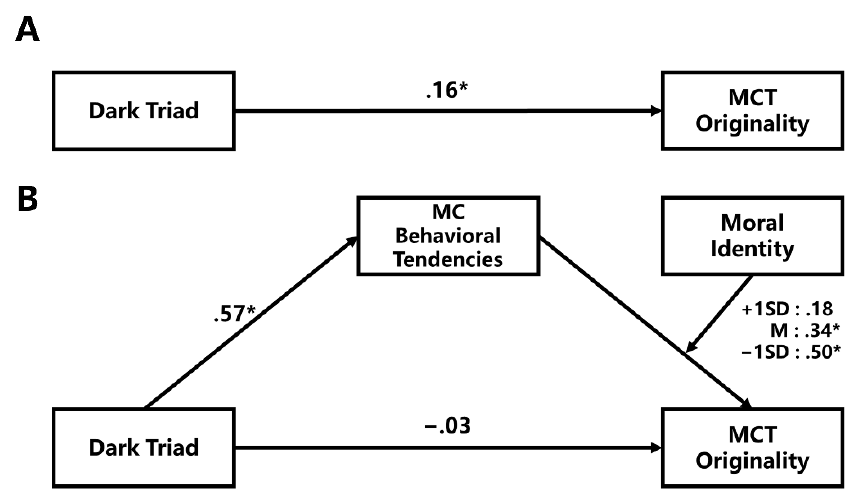
Figure 2. Results of moderated mediation analysis on MCT originality: ( A ) the total effect of the Dark Triad on MCT originality; ( B ) the moderated mediation model. Dark Triad = DD12 score; MC behavioral tendencies = MCBS score; Moral identity = MIM score; * : p < .05.